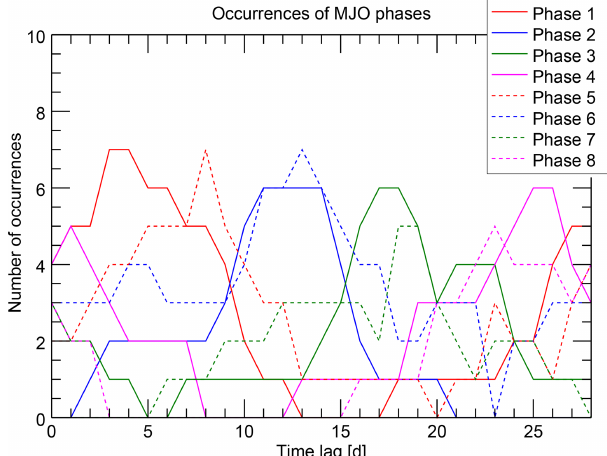
Figure 2. Number of occurrences of each MJO phase (one line per phase) as a function of time lag after solar 27-day minima. The figure shows a particular example: only solar minima during boreal winter and during a QBO easterly phase were considered. After this filtering 26 epochs remain in the analysis. Furthermore, the MJO strength on individual days has to be greater than 1. The state of the MJO is characterized by the OMI index; the Lyman alpha solar proxy was used to determine the solar